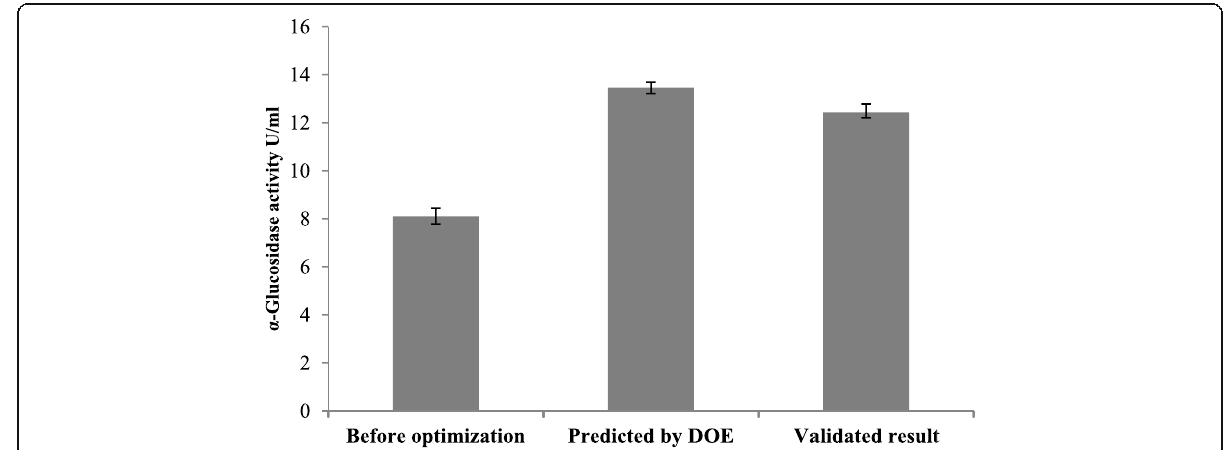
Fig. 4 Comparison of enzyme activity before and after optimization process. Error bars represents mean ± standard deviation from five experimental data